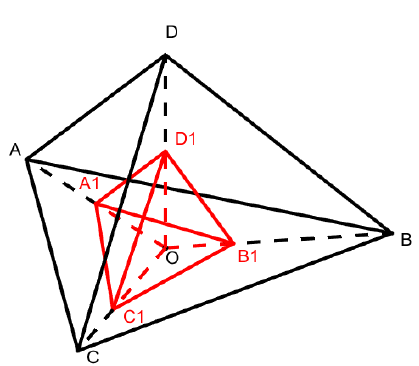
Figure 2. Human settlement environment index model.